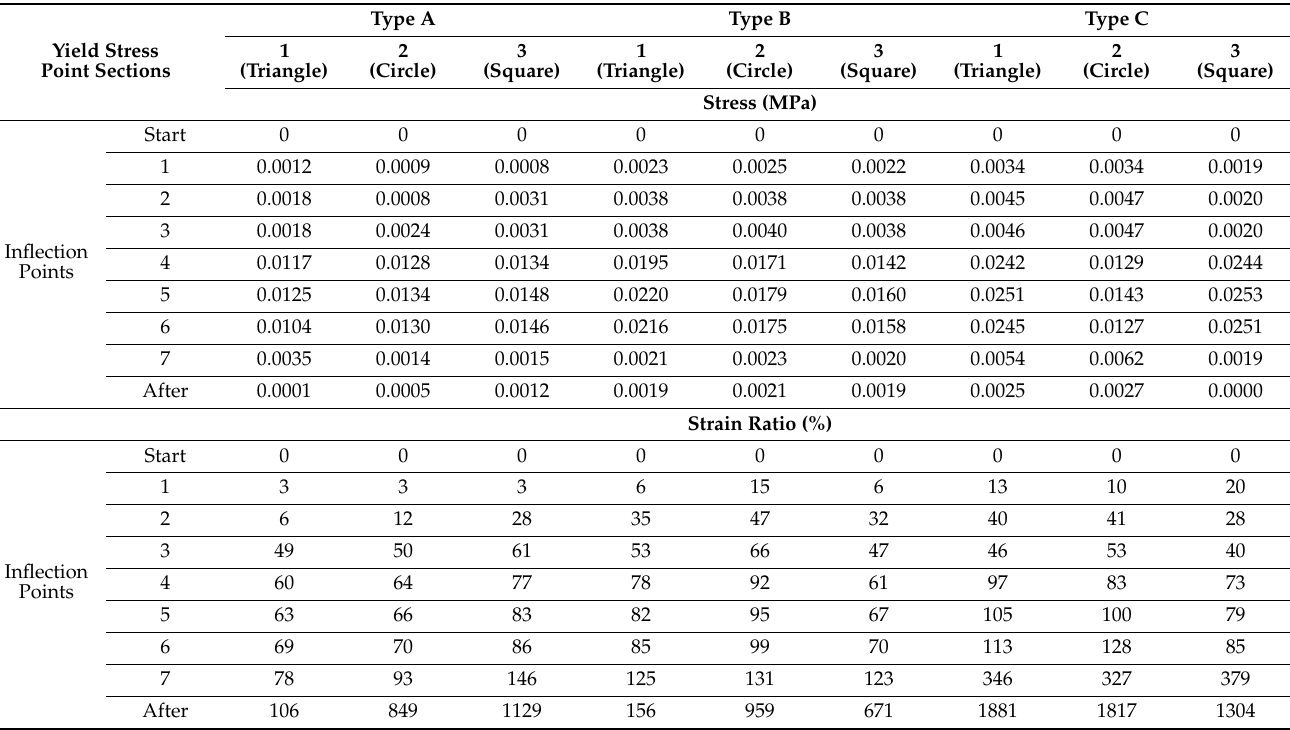
Table 5. Yield point derivation—Stress (N/mm 2 ), Strain (%).